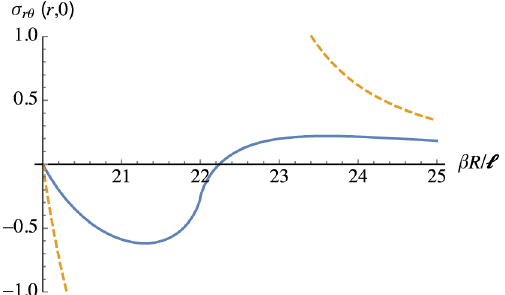
Figure 2: Classical 𝜎 0 1.1. The stress values are given in units of μ b